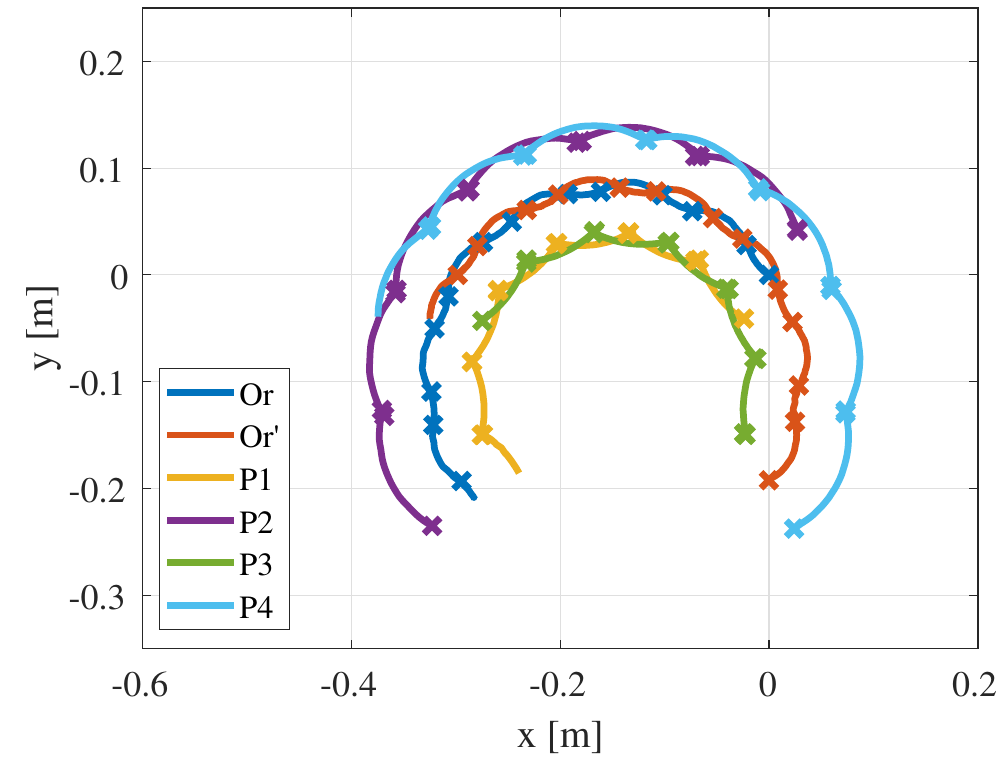
Figure 26. The trajectories of each marker in the 10th experiment of the counter-clockwise turning locomotion experiment. The “ × ” marks represent the locations of the robot coordinate with respect to each half period of the input angle function. The relative angles of the “ × ” marks (colored in blue) are the turning angles of the robot.